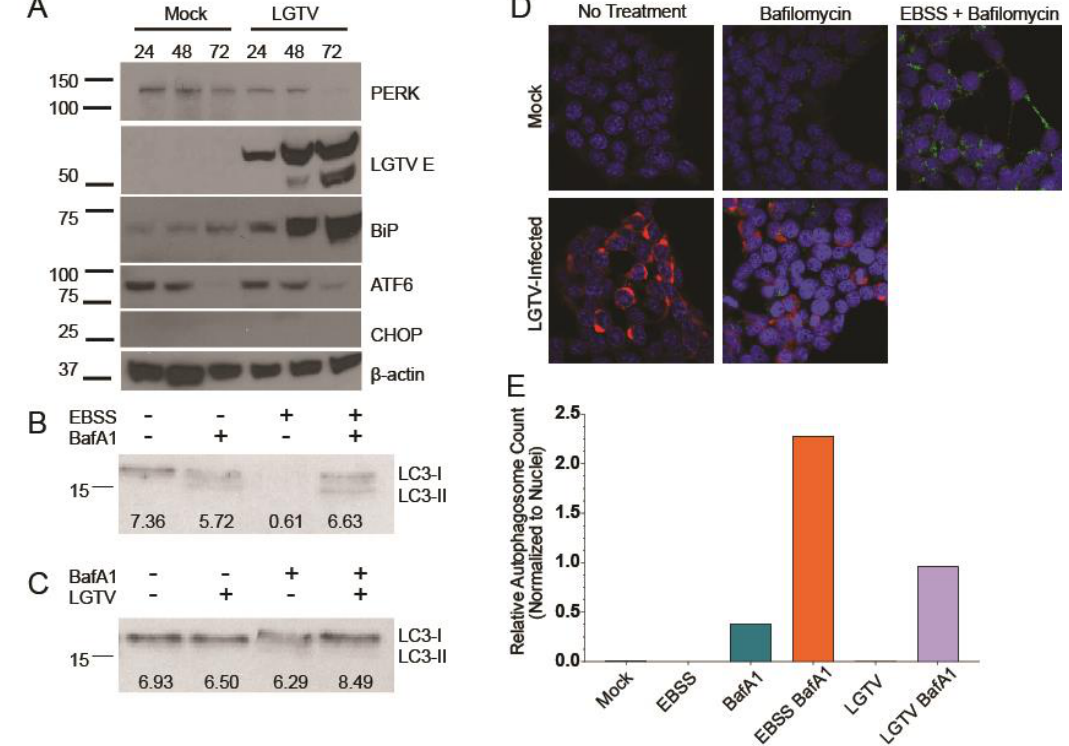
Figure 4. Reduced levels of PERK modify UPR and autophagy signaling during LGTV infection. ( A ) PERK LOW HEK293T cells express BiP highly throughout the infection time course. No observed ATF6 cleavage or CHOP induction. LGTV E increases over infection time course. ( B ) PERK LOW HEK293T cells have higher expression of LC3-I under basal conditions. Blocking autolysosomal degradation with BafA1 induced only slight increase in LC3-II showing inhibition of LC3 lipidation. Band intensity normalized to mock LC3 intensity and reported below bands. ( C ) PERK LOW HEK293T have increased total LC3 expression after 24 h LGTV infection when blocking degradation although almost entirely in unlipidated LC3-I form, indicating a block in LC3 processing. ( D ) Representative images of PERK knockdown cells treated with EBSS, BafA1, or LGTV infection. DAPI represented in blue, LC3 in green, and LGTV NS3 in red. Images acquired at 63x magnification. ( E ) Average autophagosomes per cell identified by LC3 fluorescent signal normalized to number of nuclei. Fewer autophagosomes identified in PERK LOW cells even following BafA1